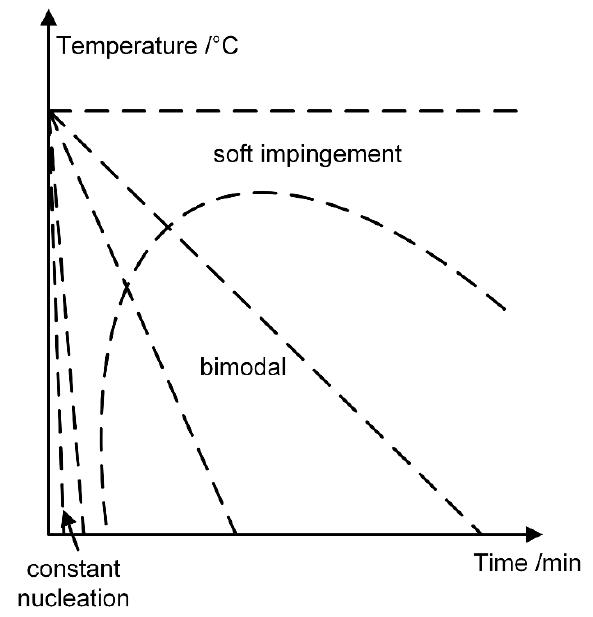
Figure 9. The e ff ect of cooling rate on the microstructure in Ni-based single crystal superalloy. Figure 9. The effect of cooling rate on the microstructure in Ni ‐ based single crystal superalloy.